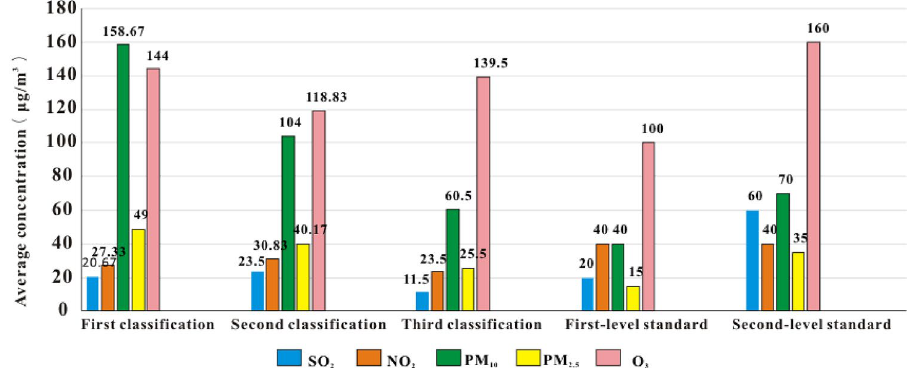
Figure 1. Comparison of the samples to be evaluated with the two levels of air